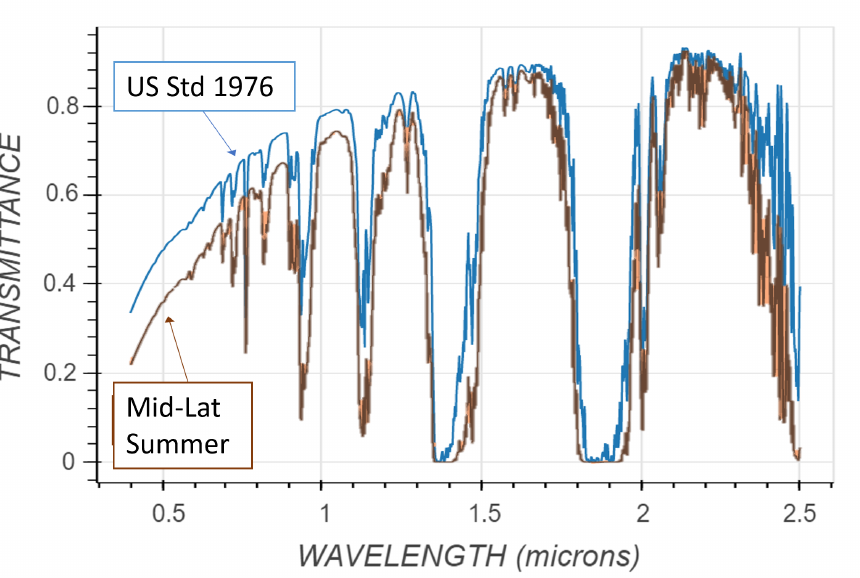
Figure 1. Two plots of transmittance for two different atmospheric models created using the MOD- TRAN online